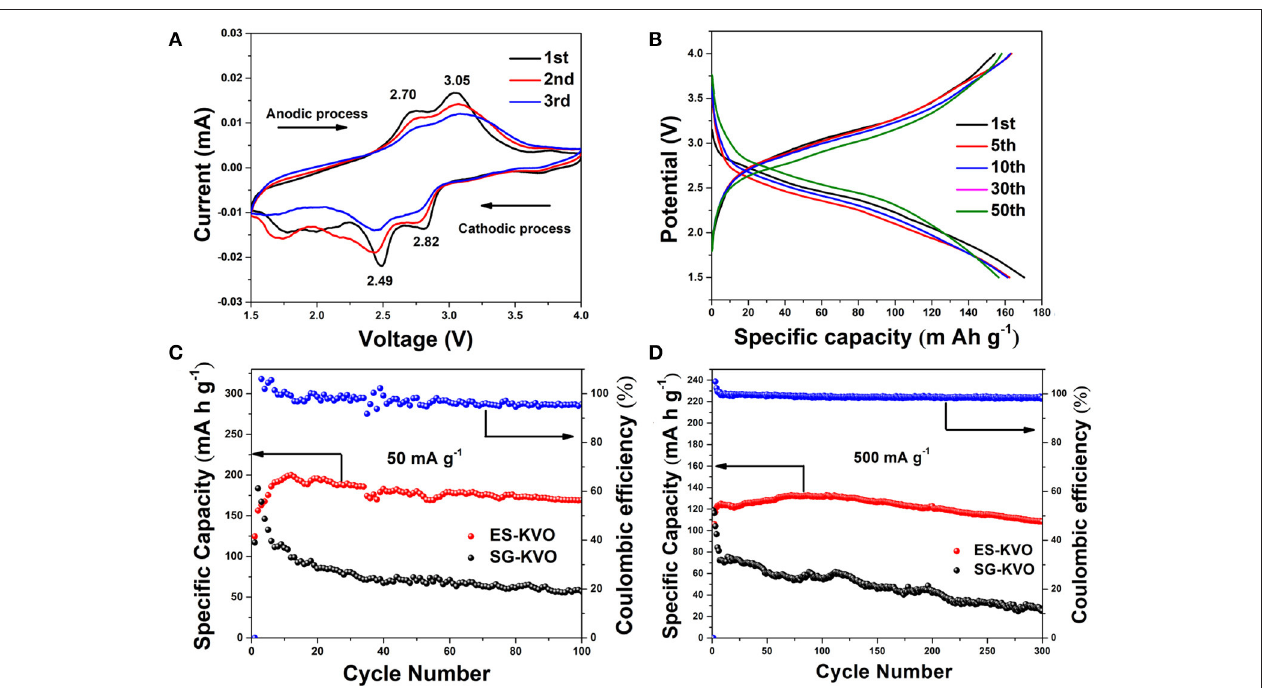
FIGURE 6 | (A) The first three CV curves at a scan rate of 0.1mV s − 1 within a voltage range of 1.5–4.0V and (B) GCD profiles of 1st, 5th, 10th, 30 th , and 50th cycle at 100mA g − 1 of the K 2 V 8 O 21 electrode; the cycling performances of ES-KVO and SG-KVO electrodes at the current density of (C) 50mA g − 1 and (D) 500mA g − 1 .